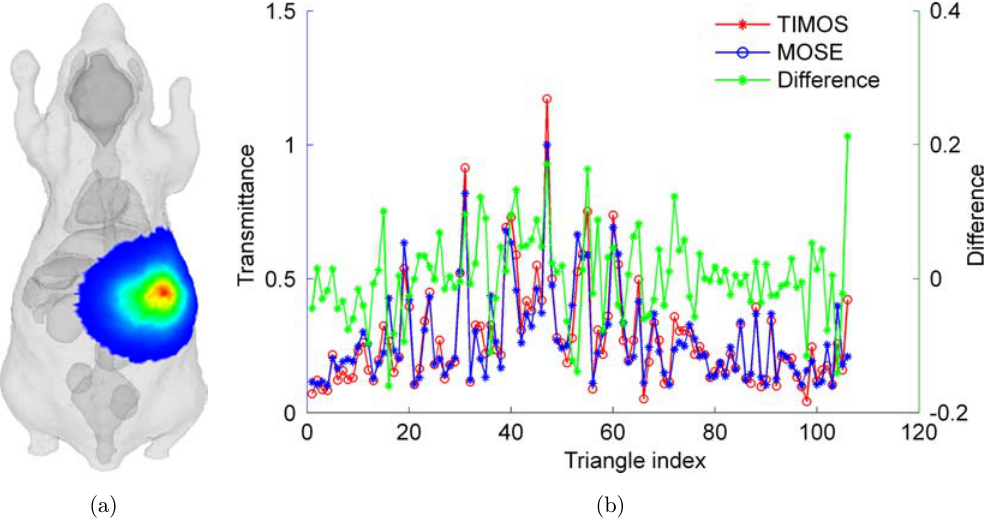
Fig. 7. Comparisons of the transmittance between the TIMOS and MOSE in case of digital mouse phantom. (a) The transmittance map of MOSE. (b) Comparison of the transmittance between TIMOS and MOSE at di®erent triangular